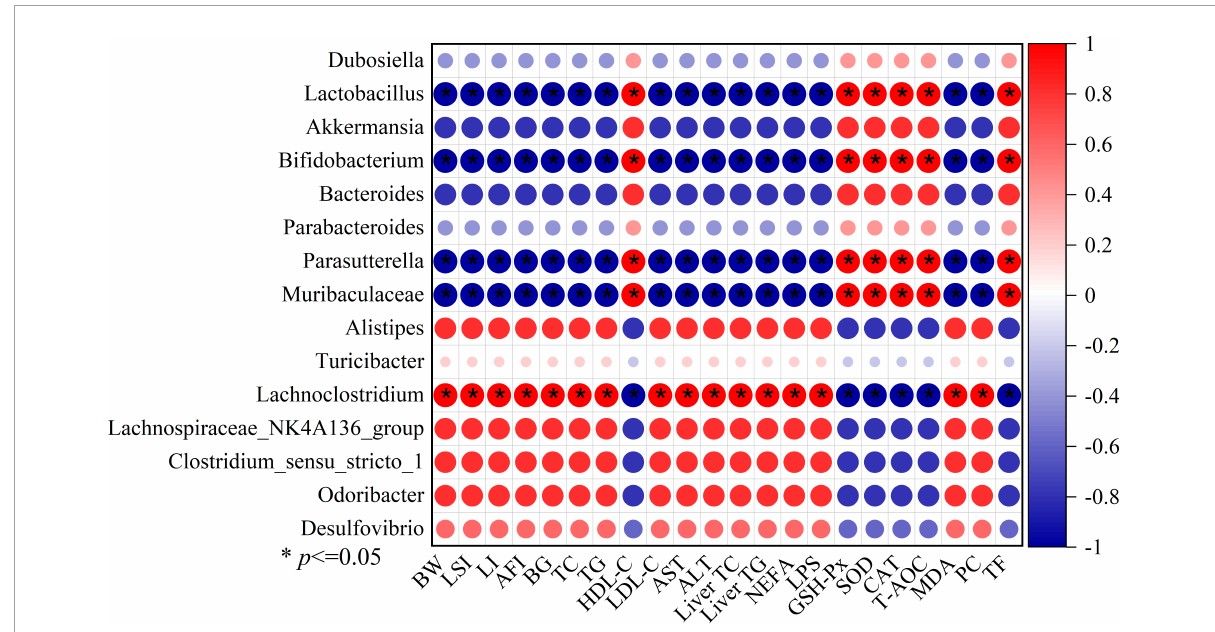
FIGURE8 Spearman’s correlation analysis between 15 key intestinal microbes and 22 obesity-related indexes, including BW (body weight), LSI (Lee’s index), LI (liver index), AFI (abdominal fat index), BG (blood glucose), serum TC, TG, HDL-C, LDL-C, AST, ALT, liver TC, liver TG, NEFA (serum non-esterified fatty acids), LPS (serum lipase), serum GSH-P x , SOD,CAT, T-AOC, MDA, PC (protein carbonyl), and TF (total fecal fat). Significant correlations with (* p <